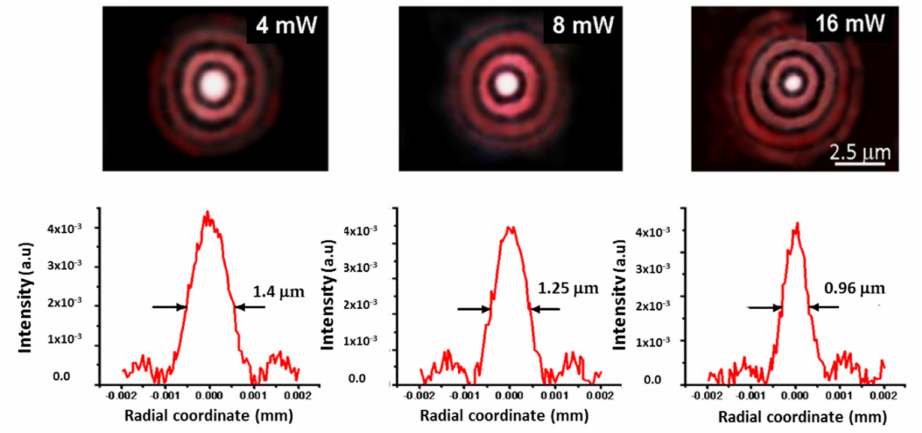
Figure 10. Upper part: photos of the focal LFRB spots magnified 2200 times at different heating powers at λ 1 = 633 nm. The scale bar indicates the effective dimensions of the focal cross − section. Lower part: Corresponding measured diametric light